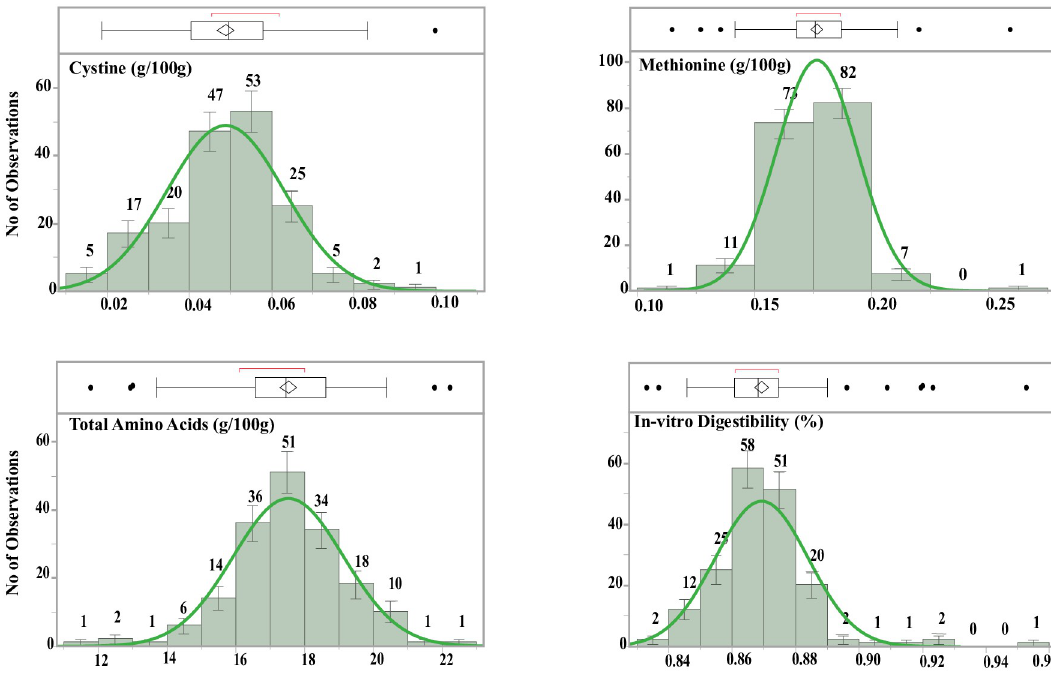
Fig 2. Dry pea cultivar distribution for cystine, methionine, and total amino acid (liberated) concentration as well as in vitro digestibility.